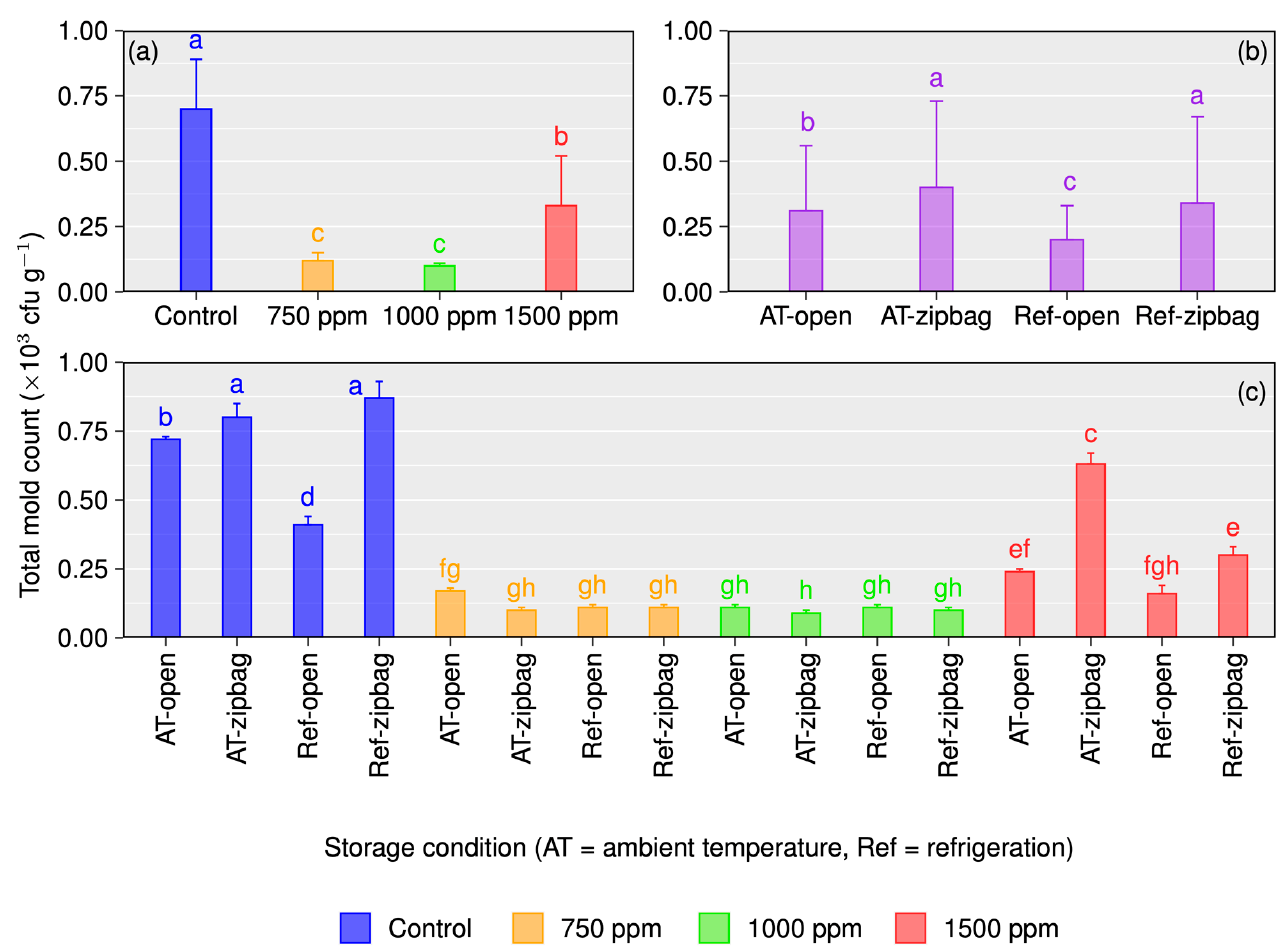
Figure 4. Total mold count (TBC) for different concentrations of chitosan-treated and untreated Gopal vogh mango stored in the open or zip-bagged at ambient temperature and refrigeration temperature ( a – c ). Means with the same letters are not statistically different from each other as per Tukey’s post hoc test ( p =